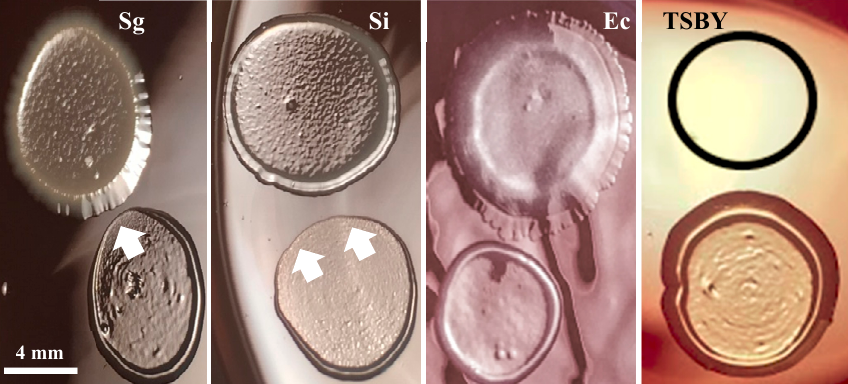
Figure 6. S. gordonii and S. intermedius antagonism against P. gingvalis. All bacteria were diluted in TSBY before plating. Spots for S. gordonii (Sg), S. intermedius (Si), E. coli (Ec), diluted 1:100, or TSBY are shown on the top of each image. Spots for P. gingivalis , diluted 1:10, are shown at the bottom of every image. White arrows point at areas of P. gingivalis spots with growth inhibition. Representative images from three independent experiments.